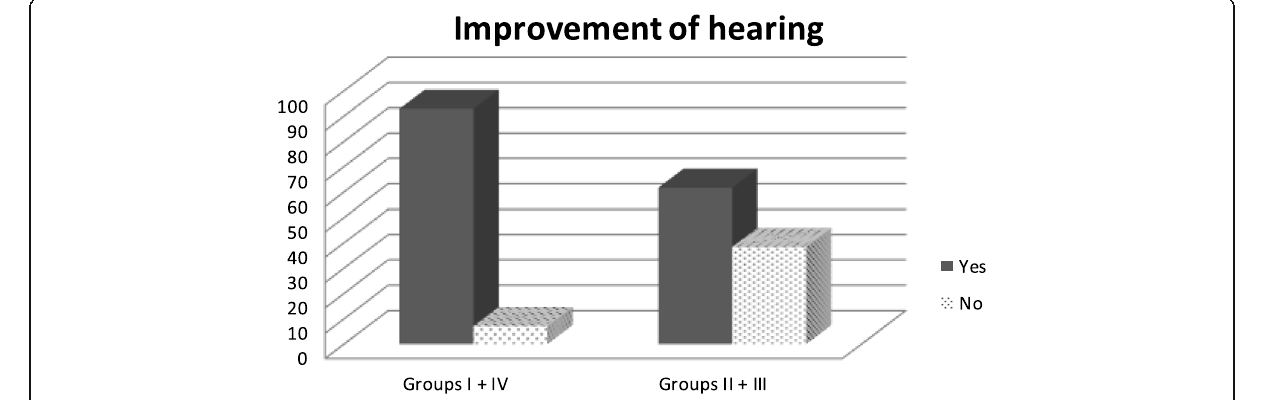
Fig. 2 The comparison between the 2 types of grafts as regards improvement of